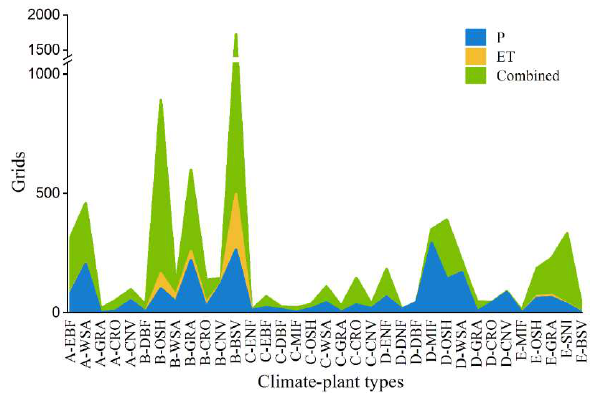
Figure 10. Statistics for the dominating factors regulating terrestrial water yield (WY) by the climate- plant types (Figure 5) across the grid cells in which WY significantly changed during 1981–2018 after correcting for multiple hypothesis testing (α = 0.05). Blue, yellow, and green indicate that WY was dominated by precipitation (P), evapotranspiration (ET), and their combined effect (Combined), re-